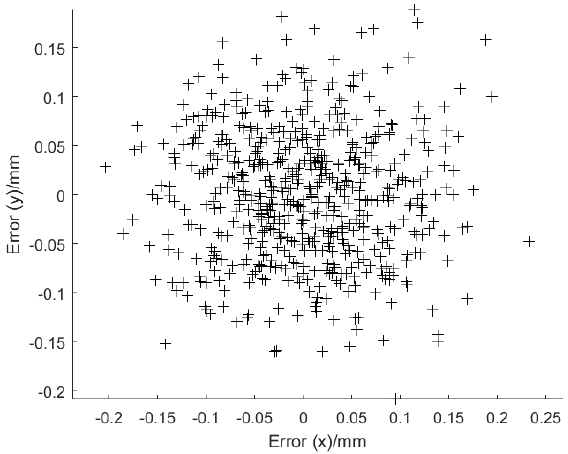
Figure 25. Error distribution of coordinate transformations.